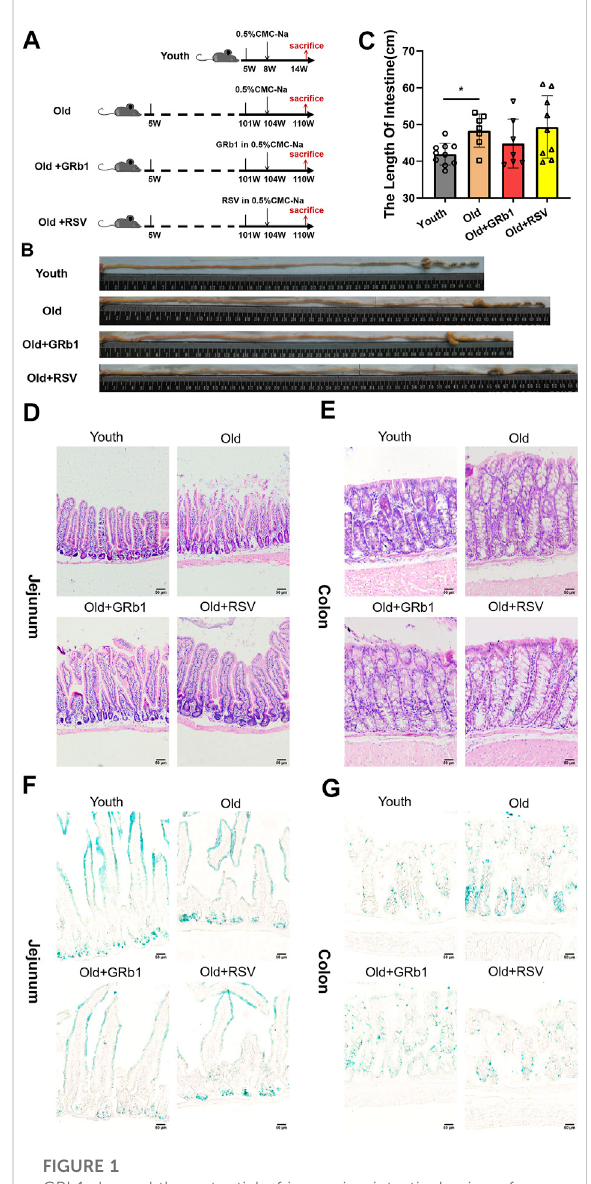
FIGURE 1 GRb1 showed the potential of improving intestinal aging of old mice. (A) The scheme of the experimental design. (B) Representative images of the intestines of mice from Youth, Old, Old + GRb1 and Old + RSV groups. (C) The length of intestines from each group. (D,E) Representative images of (D) jejunal and (E) colonal sections of H&E staining. (F,G) Representative images of (F) jejunal and (E) colonal sections of beta-galactosidase staining. * p < 0.05 compared with the Youth group. Scale bar, 50 μ m. W, weeks of age; GRb1, Ginsenoside Rb1; RSV,